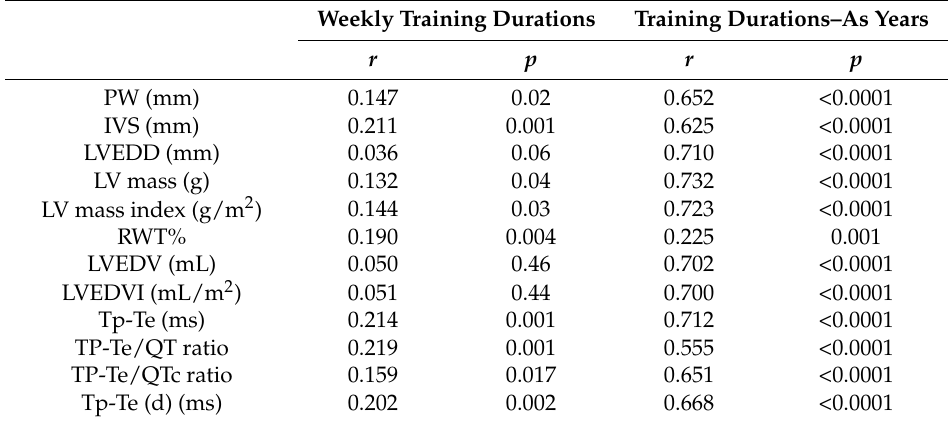
Table 3. Pearson correlation analysis between training durations, TDR indexes, and some echocardiographic parameters.